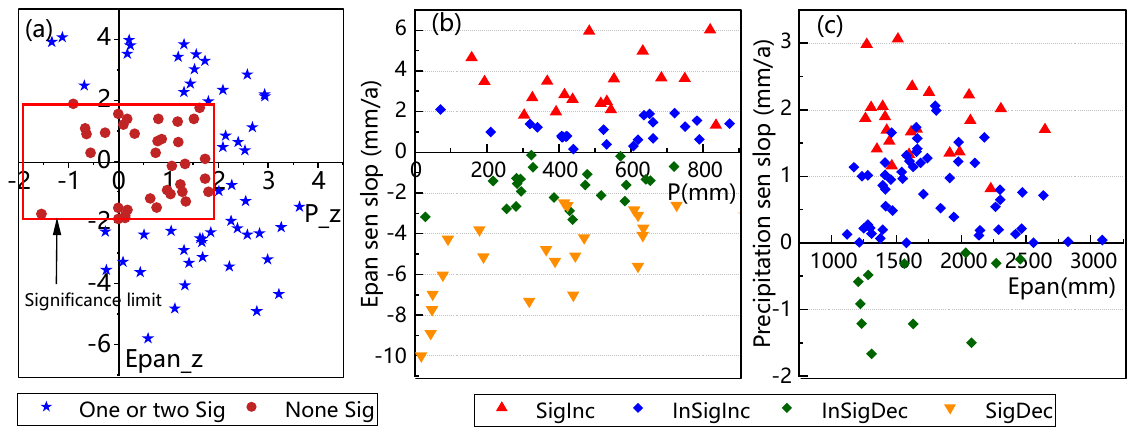
Figure 11. Comparison of the trends of precipitation and Epan at different stations on the TP. ( a ) Trend’s z-value relationship, ( b ) relationship between precipitation and Epan’s Sen’s slope, ( c ) relationship between Epan and precipitation’s Sen’s slope.